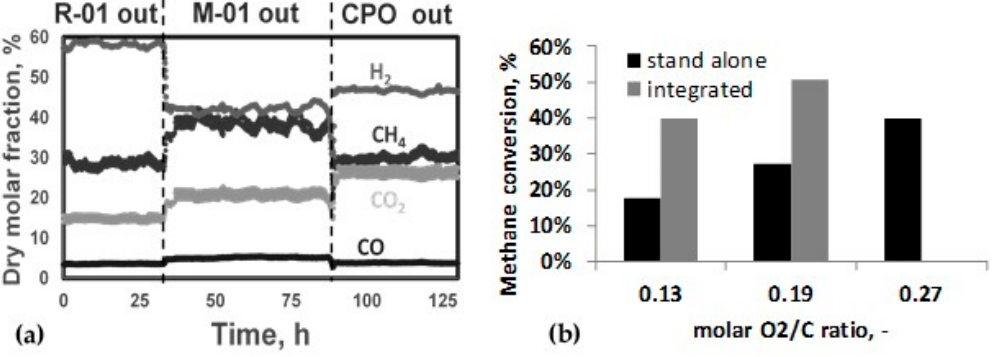
Figure 7. Performance of the membrane-based GTL process: ( a ) Stability, ( b ) Oxygen consumption.